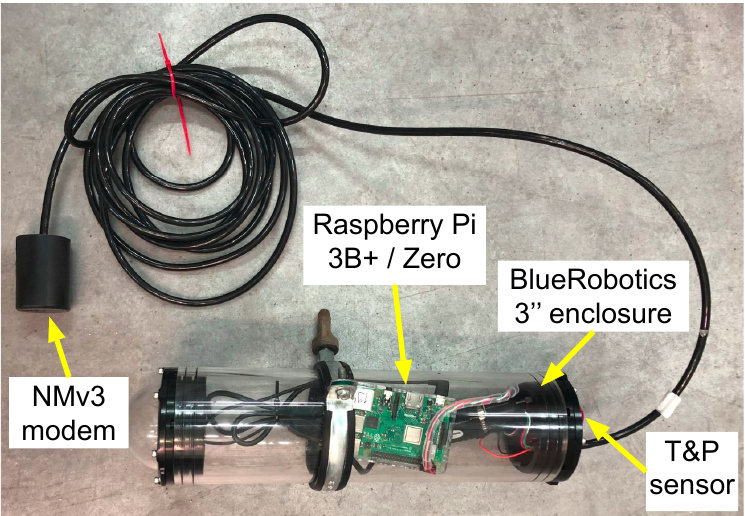
Figure 23. Underwater acoustic sensor nodes used in the Loch Earn experiments: Raspberry Pi 3B+/Zero encapsulated in a 3 (cid:48)(cid:48) BlueRobotics enclosure, with external connections to a temperature and pressure (T&P) sensor and the NMv3 acoustic